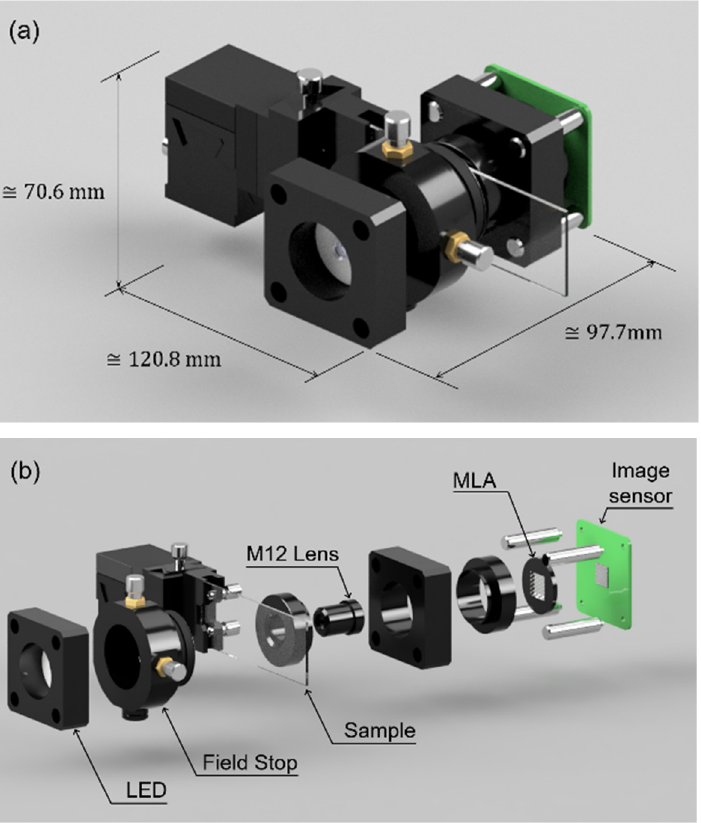
Figure 1. Scheme of the proposed hand-held and cost-effective FLMic. ( a ) The 3D modeling of the microscope. ( b ) Exploded drawing of the microscope.